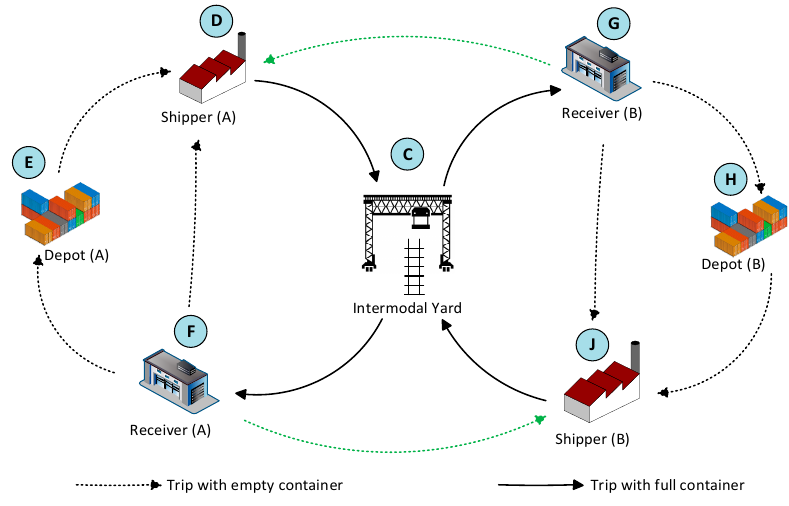
Figure 1. Intermodal freight transportation without collaboration.